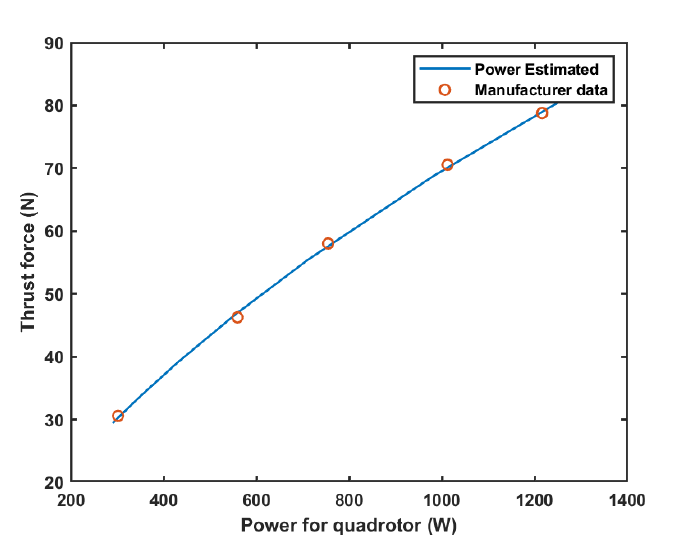
Figure 9. Power-thrust in accordance with Table